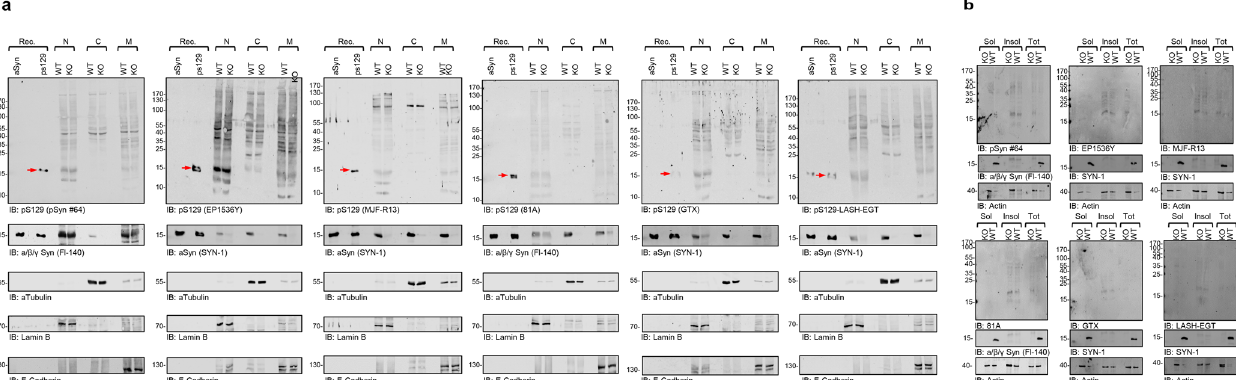
Fig. 6 Assessment of pS129 antibodies detection in the nuclear, cytosolic, and membranous fractions of aSyn KO and WT primary hippocampal neurons by WB. a , b Sequential biochemical extraction was performed on aSyn KO and WT primary hippocampal neurons cultured for 14 days (DIV14), and the pS129 level was assessed in the nuclear (N), cytosolic (C), and membrane (M) fractions ( a ) or in the soluble (sol) and insoluble (insol) fractions ( b ) by WB using the six pS129 antibodies (pSyn#64, MJF-R13, 81A, EP1536Y, GTX, and LASH-EGT). Forty nanograms of recombinant aSyn WT or phosphorylated at residue S129 (pS129, indicated by the red arrow) were used as positive controls. The pS129 antibodies were used at a dilution of 1/1000. Membranes were then counterstained by total aSyn antibodies (SYN-1 or Fl- 140 α / β / γ synuclein). aTubulin, Laminin B, and E-Cadherin were used as loading control for the cytosolic, nuclear, and membrane fractions, respectively ( a ). Actin was used as a loading control for the soluble and insoluble fractions ( b ). All blots were derived from the same experiment and were processed in